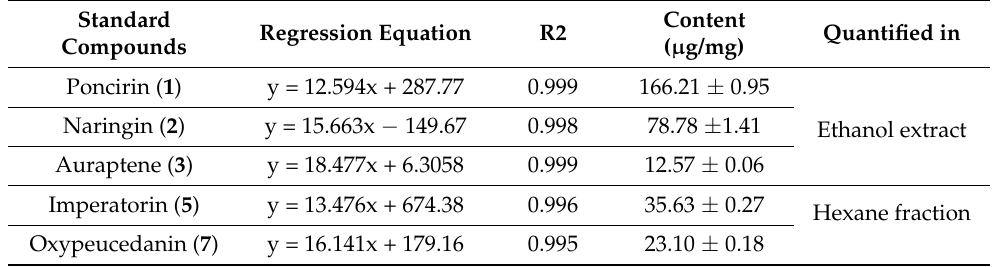
Table 1. Quantification of isolated compounds using UPLC.